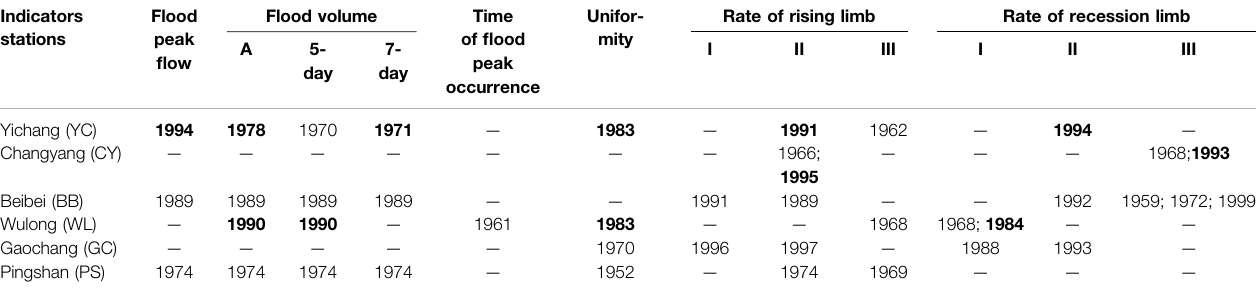
TABLE 6 | List of abrupt change points of evaluation indicators at the six stations in the UYR by PMF. Indicators stations